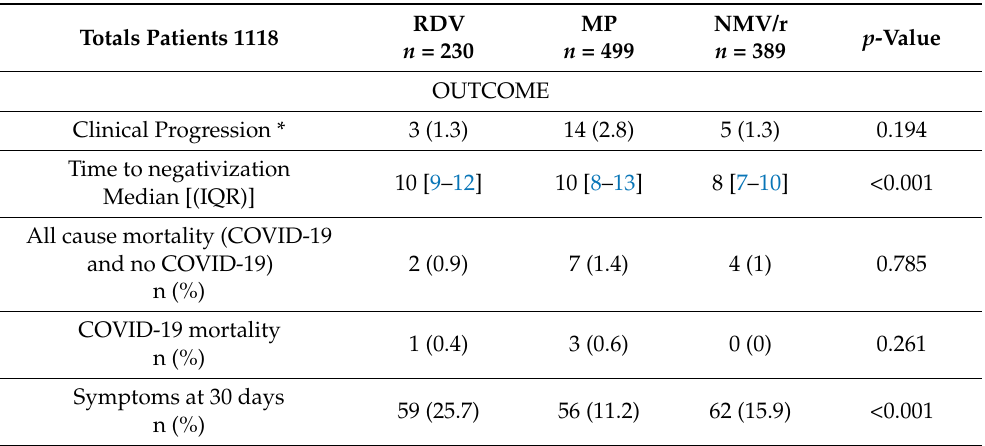
Table 3. Results of univariable analysis of patients’ clinical evolution by the two endpoints: composite outcome and symptoms at 30 days. * Composite outcome: pneumonia, ARDS, COVID-19 Death, Non-COVID-19 Death. IQR: interquartile range.